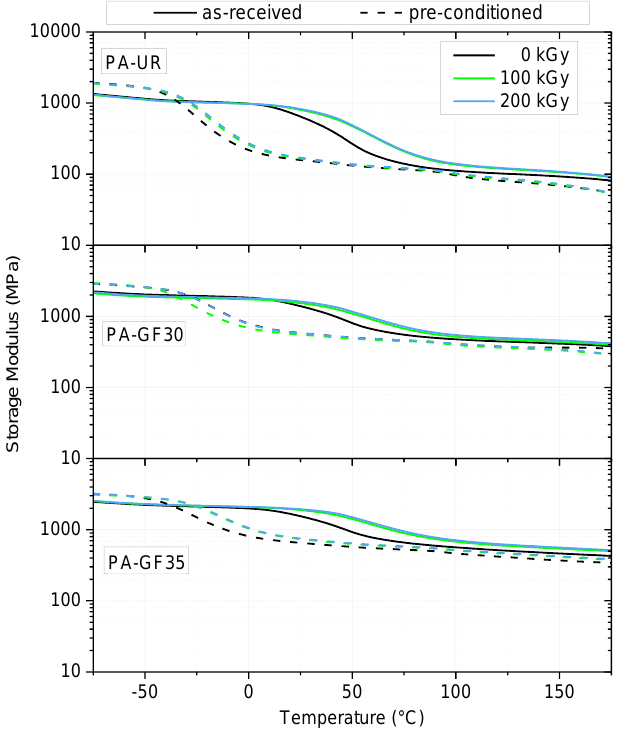
Figure 6. DMA curves for the three PA grades depicting the effect of water absorption and irradiation dose.